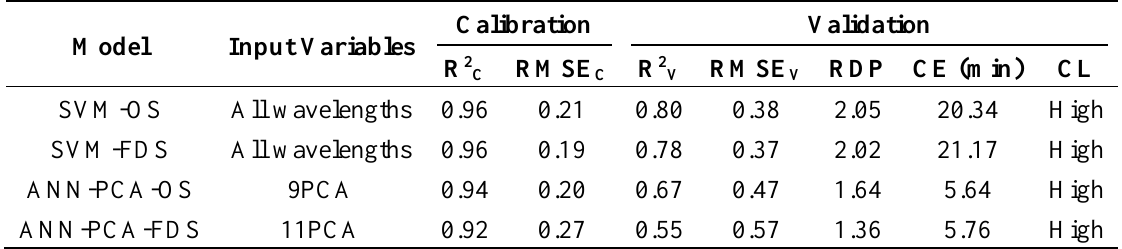
Table 8. The best-performing support vector machines (SVMs)-based LNC models for the calibration and validation sets.